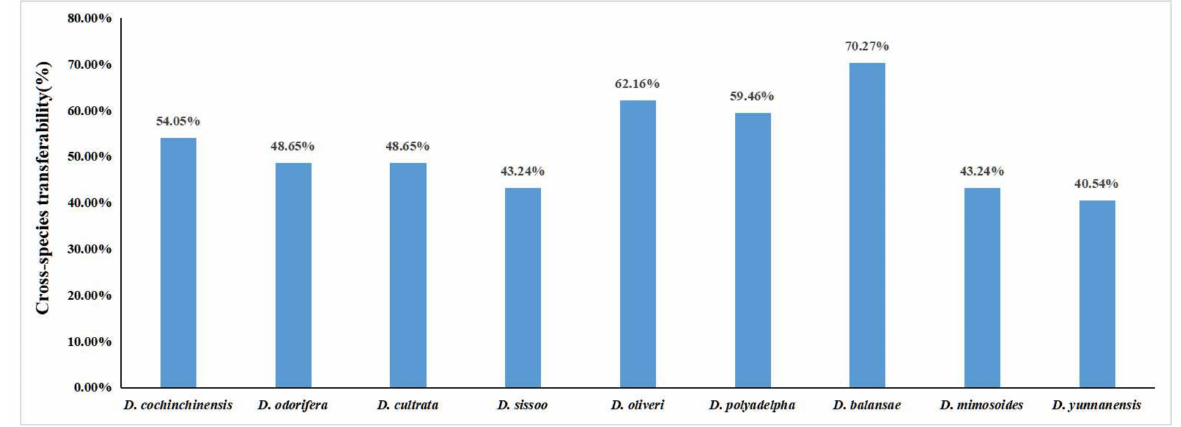
Figure 3. Cross-species transferability of gSSR markers developed in D. hupeana